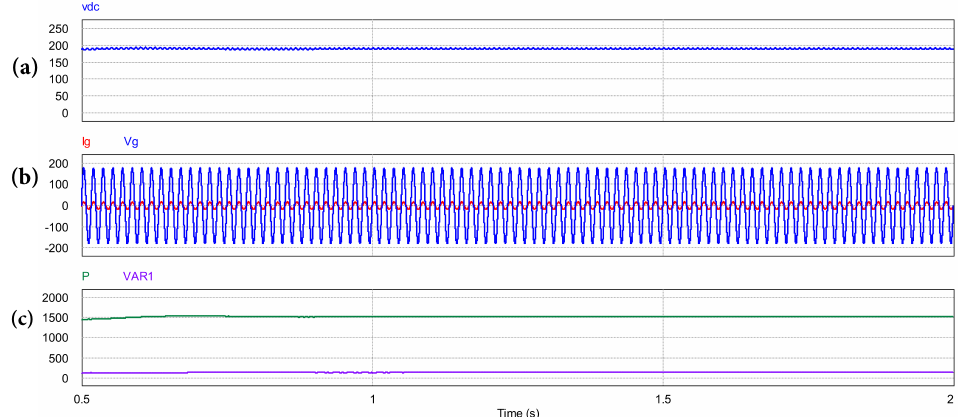
Figure 23. 1.5 kW DC-AC single phase full bridge converter, closed loop performing in inverter mode. ( a ) DC bus voltage, ( b ) grid current (red) and grid voltage (blue) , ( c ) active (green) and reactive (purple) power.